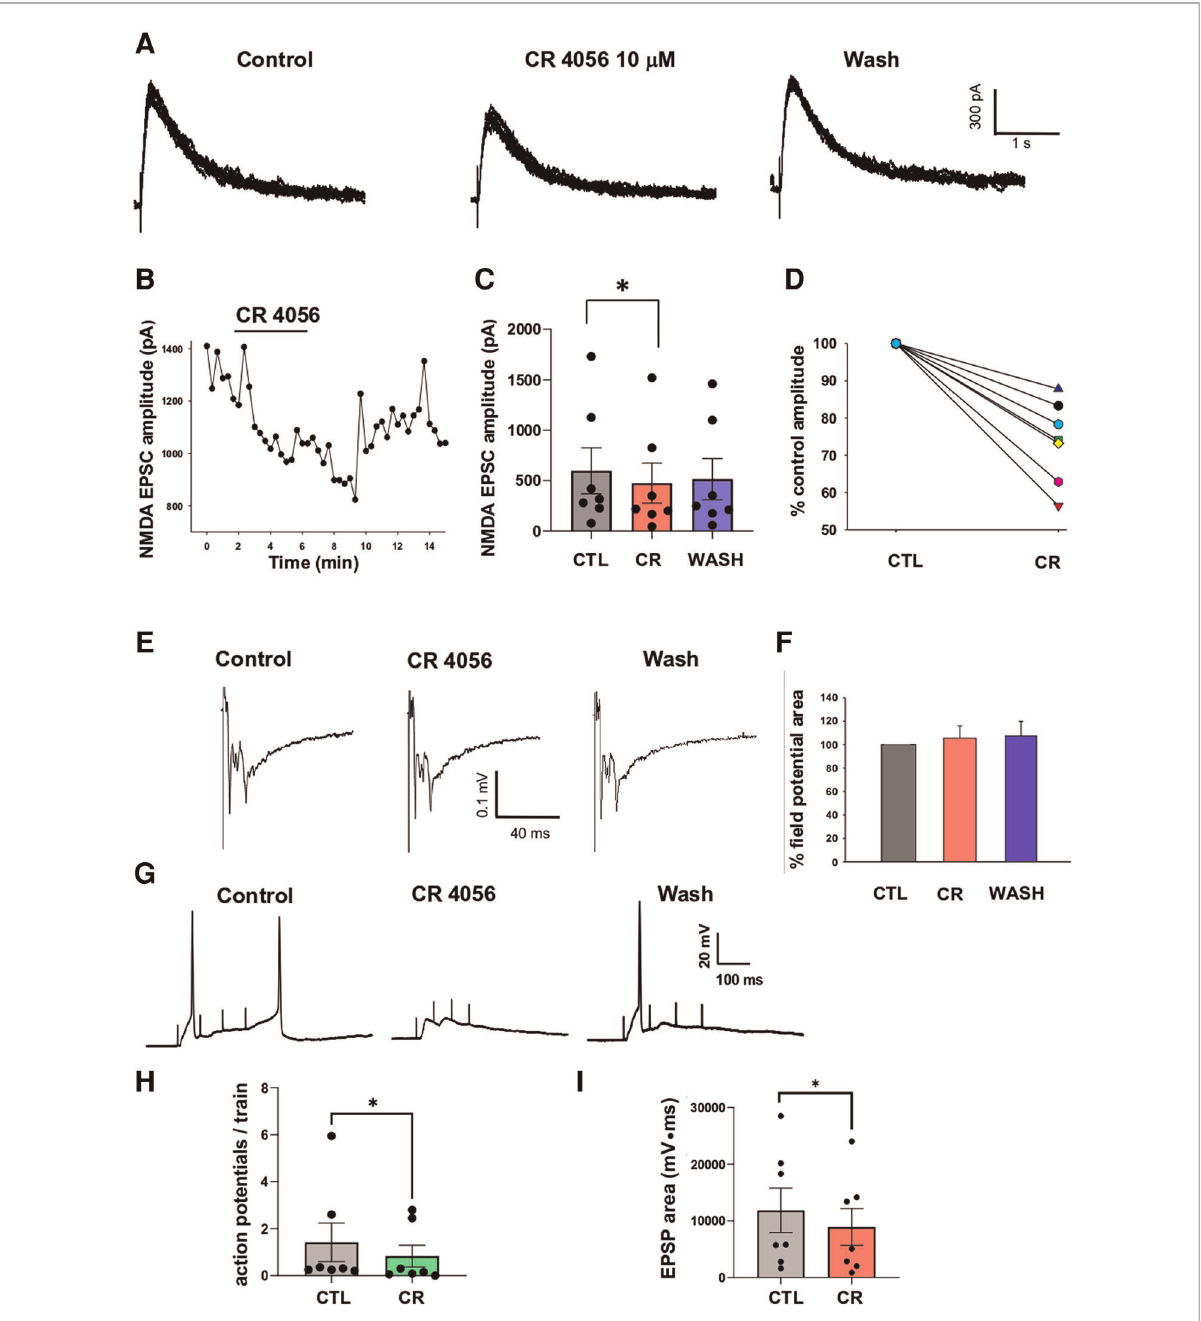
FIGURE 4 Application of CR 4056 depresses NMDA mediated synaptic responses evoked in rat dorsal horn lamina II. ( A ) Examples of NMDA EPSCs recorded from a lamina II neuron in rat spinal cord slices (7 – 8 consecutive traces are superimposed). NMDA currents were evoked by stimulating the dorsal root and were recorded in voltage-clamp at +40 mV, in the presence of NBQX (10 µM), Bicuculline (10 µM) and Strychnine (0.5 µM). 5 min application of CR 4056 (10 µM) caused the decrease of NMDA EPSC amplitude, that was partially reversible in some neurons. ( B ) Time course of the CR 4056 effect on the EPSCs shown in A. Bar indicates the duration of CR 4056 application. ( C ) CR 4056 signi fi cantly depressed NMDA EPSC amplitude in the sample of lamina II neurons tested compared to control (CTL) (One-way ANOVA repeated measures test, followed by Tukey test CTL vs. CR: p =0.02; CTL vs. wash and CR vs. wash: p >0.05; n =7.). ( D ) Percentage changes of NMDA EPSC amplitude observed in six different neurons (represented by the different lines). ” . ( E ) Examples of fi eld potentials, extracellularly recorded from rat dorsal horn laminae I-II and evoked by root stimulation. ( F ) Histogram showing the percentage fi eld potential area (mean +/ − SE) in the presence of CR4056 (CR) and after washing (WASH), compared to control (CTL). Field potential area was not changed after CR 4056 (One-way ANOVA repeated measures test, p >0.05, n =6). ( G ) Recordings obtained from a lamina II neuron in current clamp, by stimulating the dorsal root with 4 consecutive pulses at 10 Hz. Application of CR 4056 decreased the summated EPSPs and the fi ring of action potentials (APs). ( H,I ) The average number of APs generated at each train ( H ) and the area of the summated EPSPs ( I ) were signi fi cantly reduced by CR4056 ( H : Wilcoxon Signed Rank test, p =0.01, n =7; I : Paired t -test, p =0.01, n =7). See also Supplementary Materials for raw data and statistical